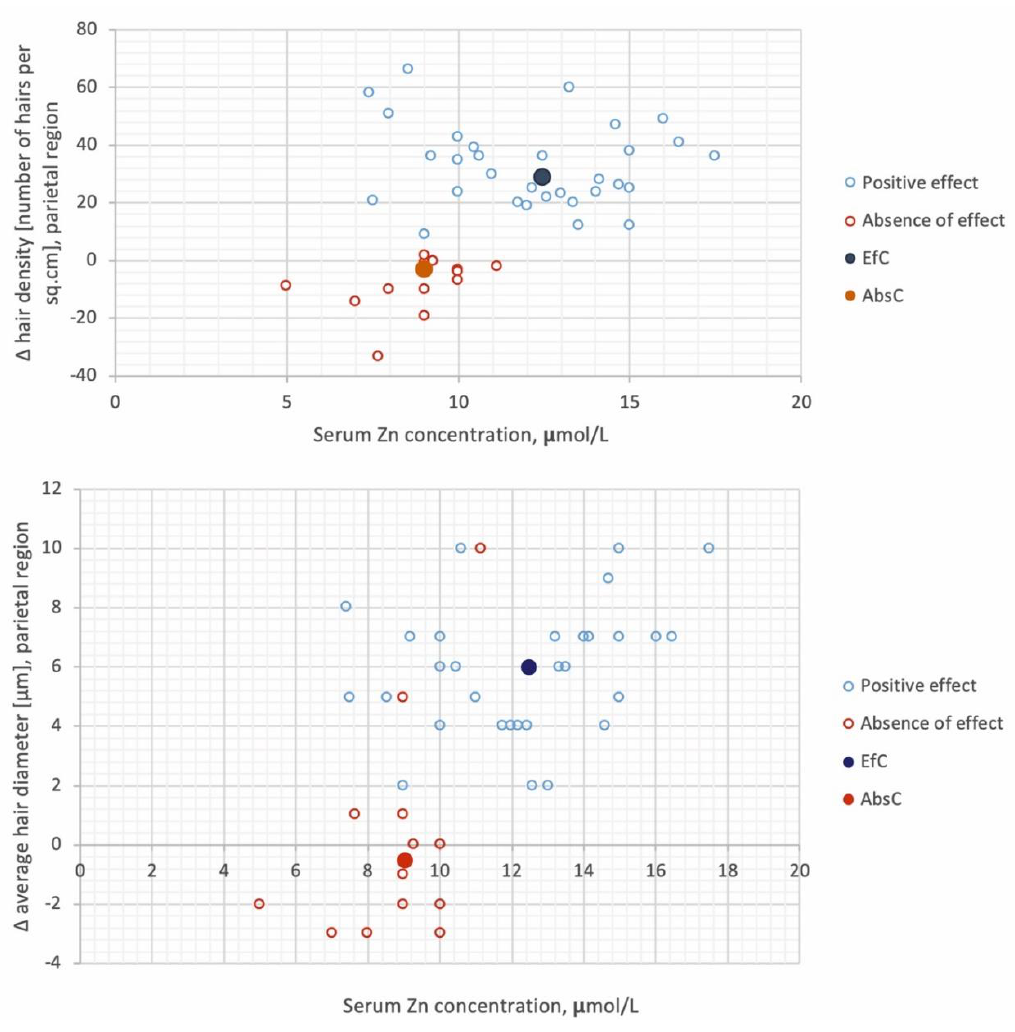
Figure 2. Serum zinc concentration versus change ( ∆ ) in hair density and ∆ in average hair diameter in parietal region. Medians in the studied groups are shown as EfC (positive effect) and AbsC (absence of effect).